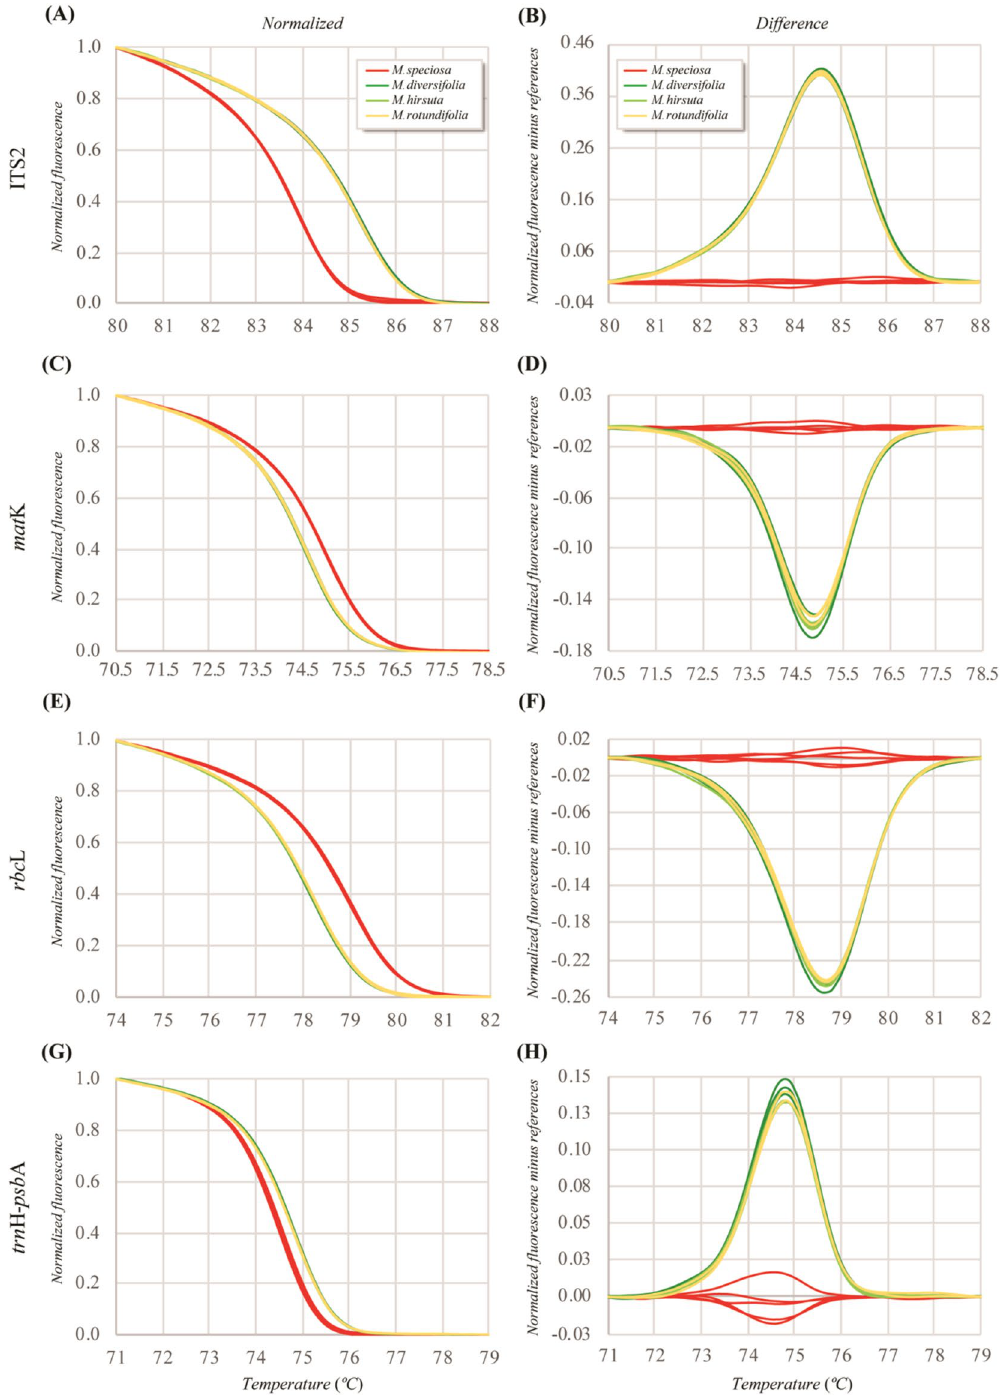
Figure 1. Bar-HRM analysis of M. speciosa , M. diversifolia , M. hirsuta and M. rotundifolia , shown in terms of normalized plots ( A , C , E , G ) and difference plots with M. speciosa as the reference ( B , D , F , H